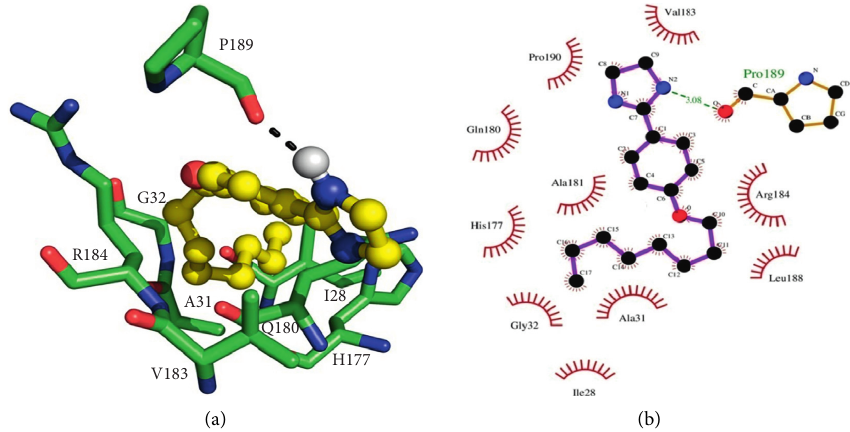
Figure 12: A 2D schematic diagram of the interaction between 14 and CviR.